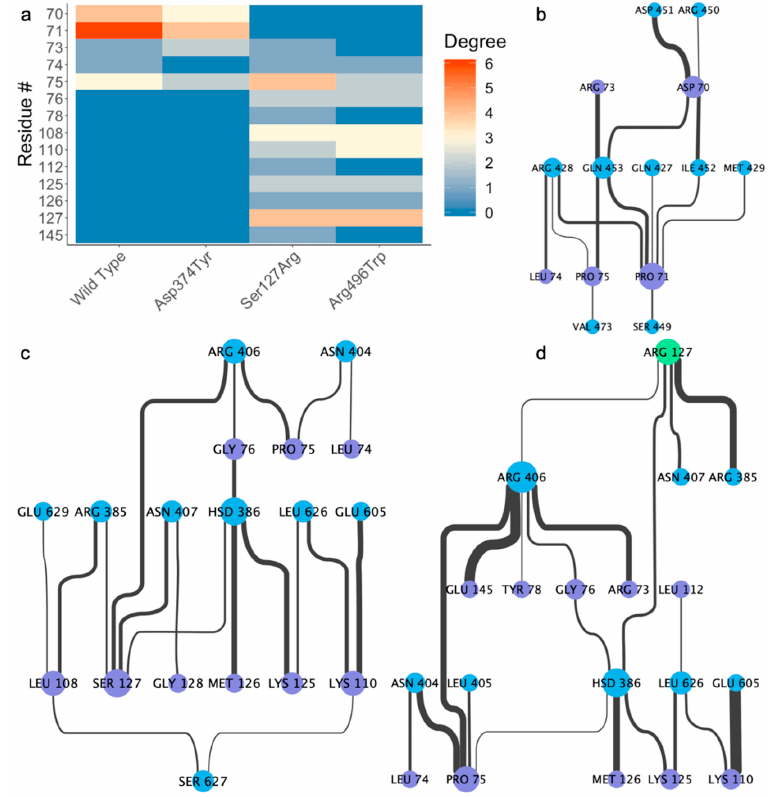
Figure 2. Contacting residues in the prodomain of PCSK9. ( a ) Number of contacts. (degree) in the prodomain of PCSK9 in each system. No residues in the crystal structure met the contact criteria used. Residue interaction network between the prodomain of PCSK9 and LDLR in the ( b ) wild-type, ( c ) Arg496Trp, and ( d ) Ser127Arg systems. Edge weight indicates strength of interaction, and node size indicates number. of interactions (connectivity or degree in residue-residue networks).